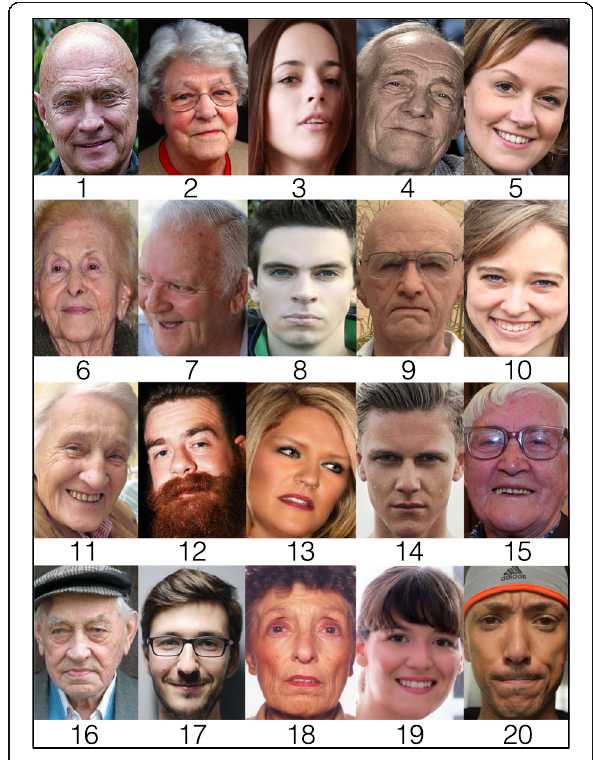
Fig. 2 Example array challenge from Experiment 1. Participants were asked to indicate any photos that show a mask. The array always contained 19 real face photos and 1 mask photo. In this example, image 9 shows author RJ in the old male mask